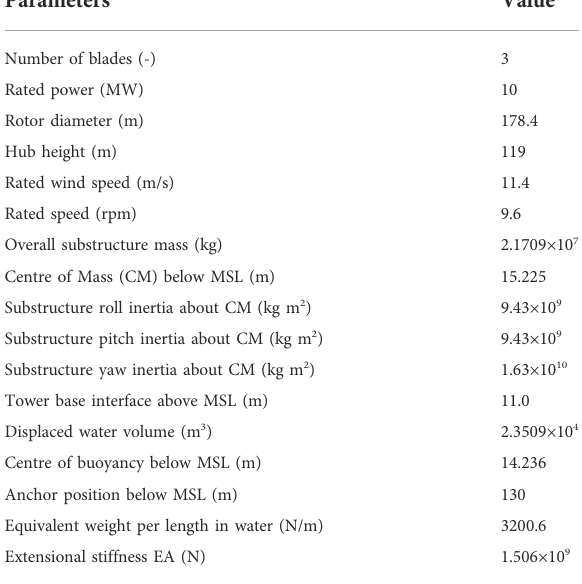
TABLE 1 Properties of DTU -10 MW wind turbine and OO-Star Semi fl oating substructure. Parameters